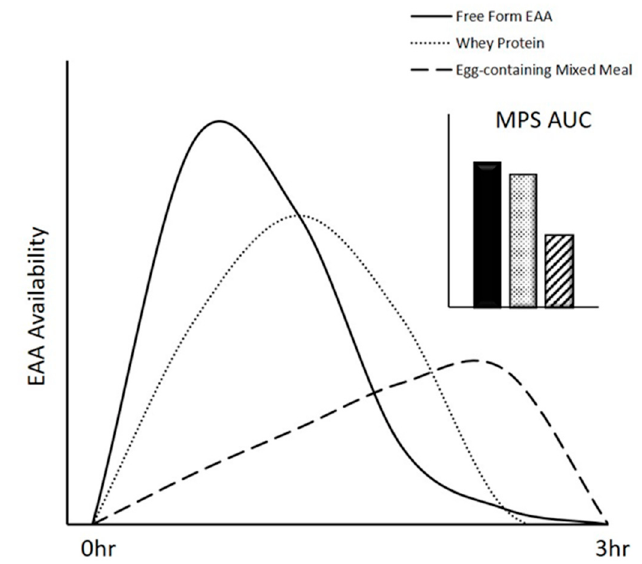
Figure 2. Theoretical comparison of magnitude changes in muscle protein synthesis (MPS) in response to the ingestion of supplemental free-form essential amino acids (EAA), whey protein, and a protein-containing mixed